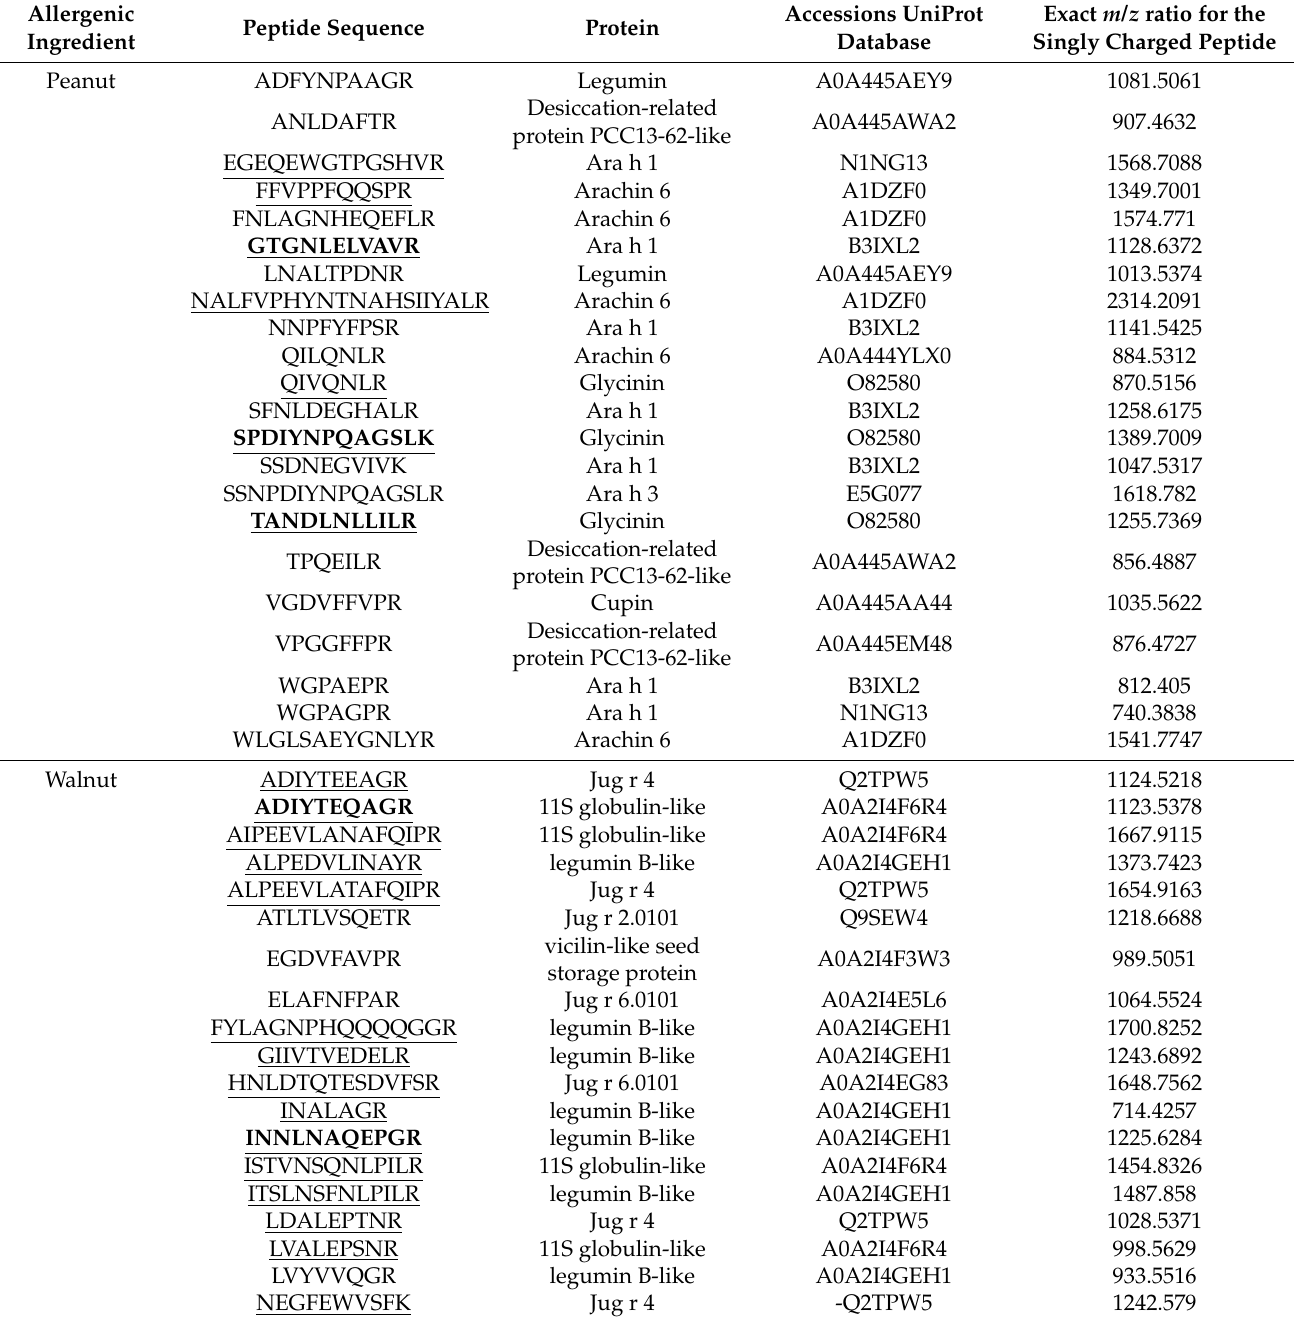
Table 2. List of common peptide sequences detected in the tryptic digests of protein extracts obtained from raw or roasted tree nuts and peanuts and complying with constraints posed during this study (sequence length between 7 and 20, absence of C and M and of the NG motif, and absence of missed cleavages). The protein to which each peptide belongs is reported, along with its UniProt database accession number. The exact m / z ratio for the singly charged ion is also reported for each peptide. Underlined sequences correspond to peptides that were reliably identified in the tryptic digest of proteins extracted from an in-house prepared cookie incurred with 200 mg · kg − 1 of each allergenic ingredient. Among them, sequences written also with bold characters were finally selected for the quantification of tree nuts and peanuts in the incurred cookies. See text for